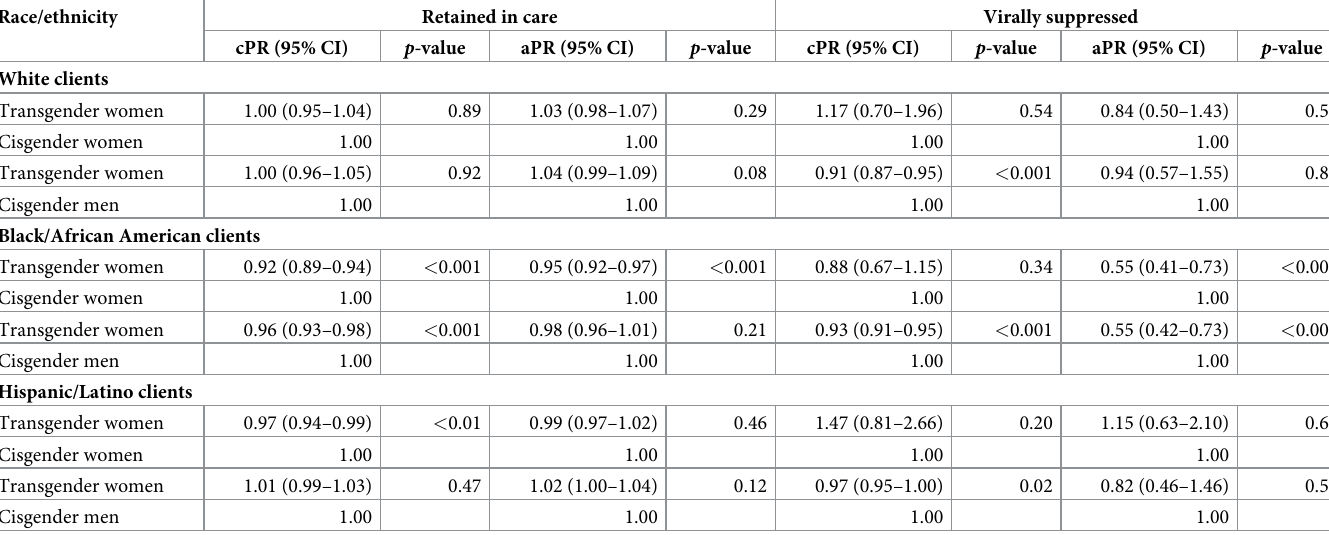
Table 4. Association between gender and retention in care and viral suppression in the HRSA RWHAP, by race/ethnicity, 2016. Race/ethnicity Retained in care Virally suppressed White